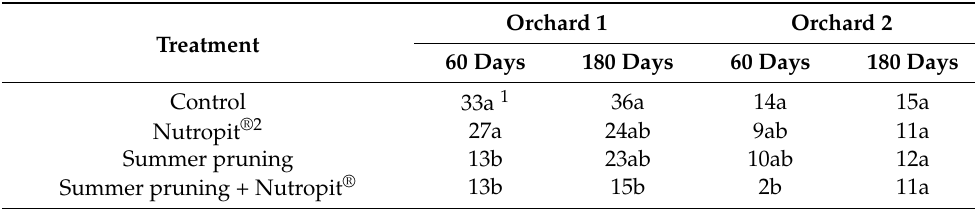
Table 2. Effect of sustainable techniques on bitter pit incidence (%) in apple cv. ‘Reinette du Canada’ during